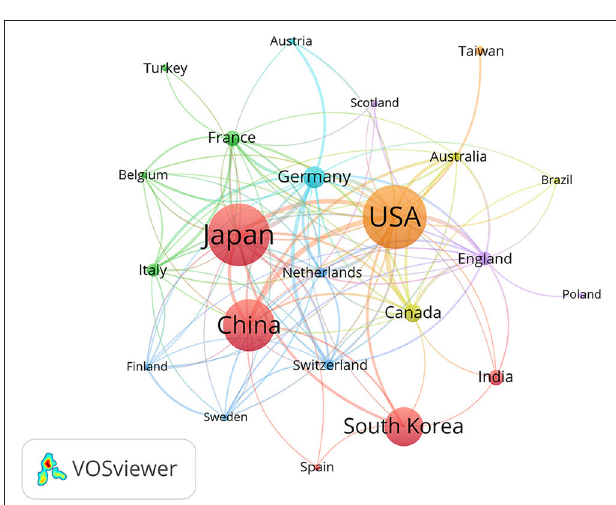
FIGURE 3 | The co-authorship network visualization map of countries/regions related to MMA. Lines between clusters represented occurrence and the size of node was positively associated with the number of publications.